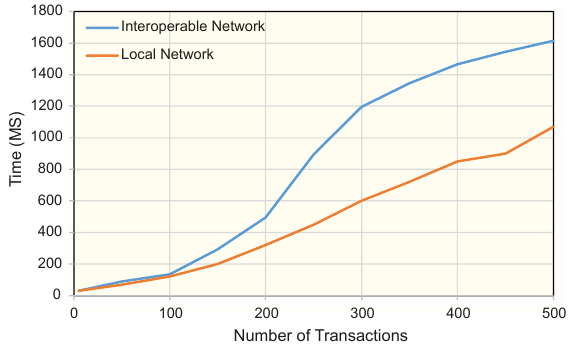
Figure 4. Transaction execution and